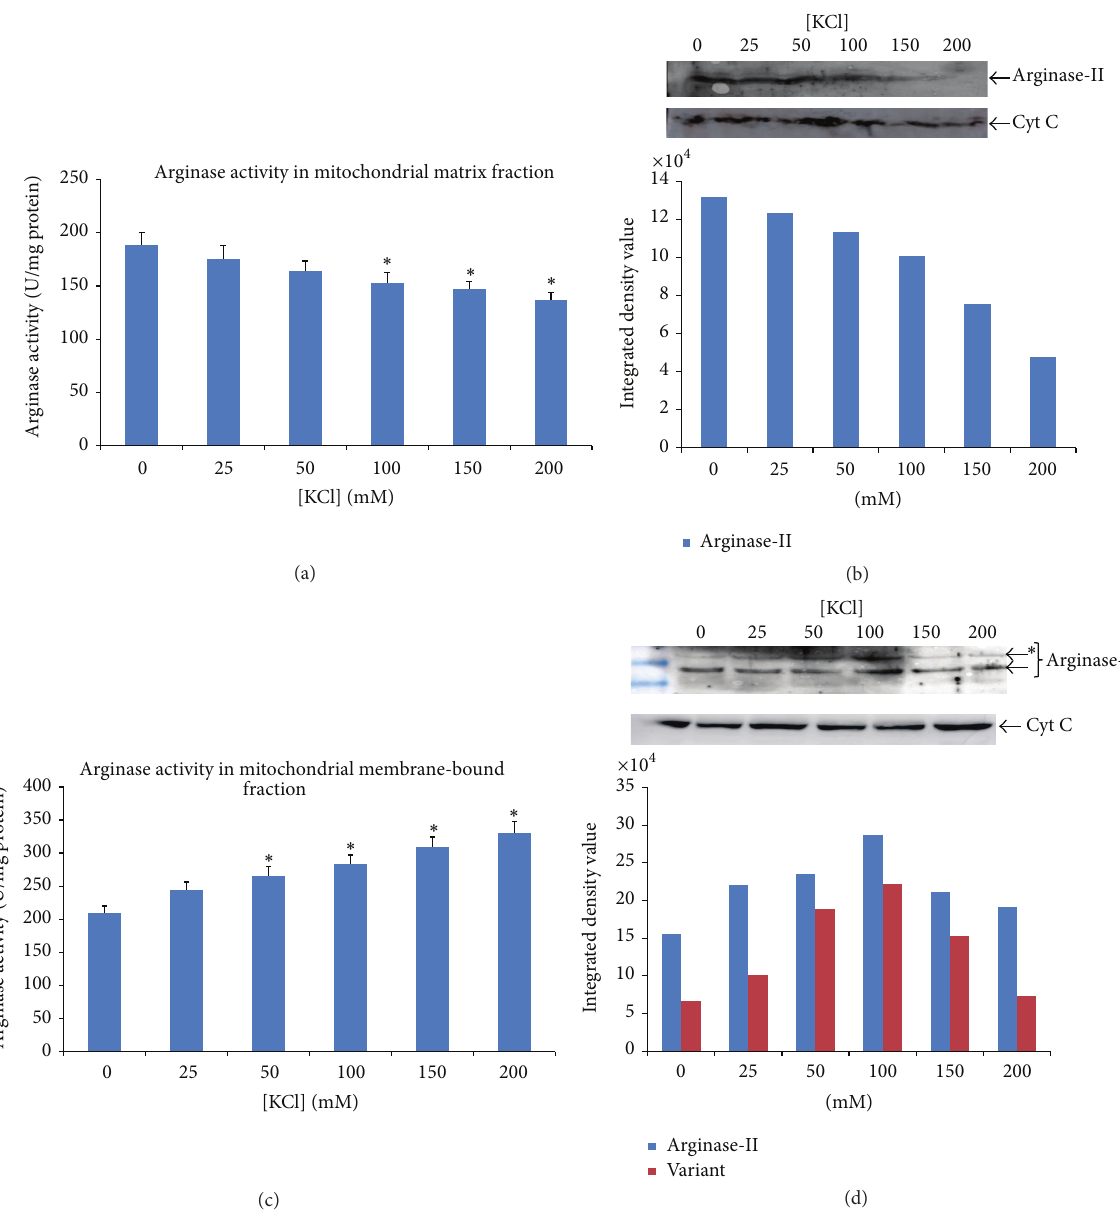
Figure 5: Data showing the activity of arginase under influence of increasing KCl concentration on isolated mitochondrial fraction in experiment set 2 in which mitochondria were isolated first and then washed with different concentration of KCl in homogenizing buffer. (a) Graph shows decreasing activity of arginase with the increasing concentration of KCl in the homogenizing buffer. Data is mean of three experiments and histogram represents mean ± SD; ∗ 𝑃 < 0.05 . (b) The mitochondrial matrix fraction probed against anti-arginase-II cross reacts with single band of 40 kDa. The intensity of band was decreasing with increasing concentration of KCl. Cytochrome C (Cyt C) was taken as loading control. (c) The increased activity of arginase in membrane-bound fraction was observed with increasing concentration of KCl in isolation buffer; ∗ 𝑃 < 0.05 . (d) The membrane-bound fraction probed against anti-arginase-II has shown band of 40kDa which is expected for anti-arginase-II along with the band of 50kDa that shows progressive increase with increasing concentration of KCl; ∗ The variant that is immunoreactive with anti-arginase-II. Cytochrome C (Cyt C) was taken as loading